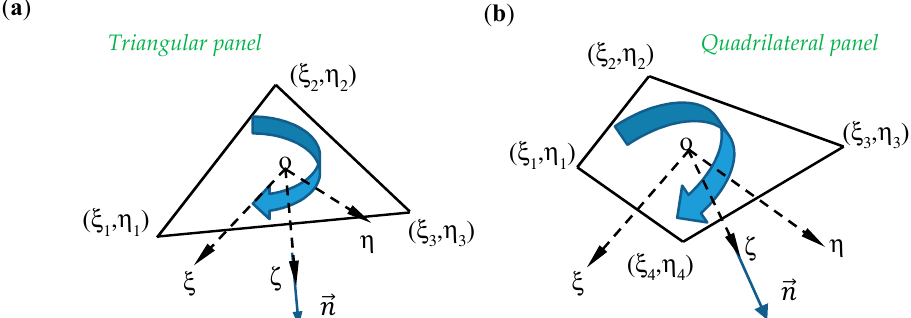
Figure 3. Illustration of the local coordinate system of each panel, in triangular shape ( a ) or quadrilateral shape ( b ). The origin o normally locates at the centroid of each panel, and the positive ζ -axis points to the normal direction of the panel. The sequence of vertices is arranged in accordance with the normal direction that points into the inside of the body.